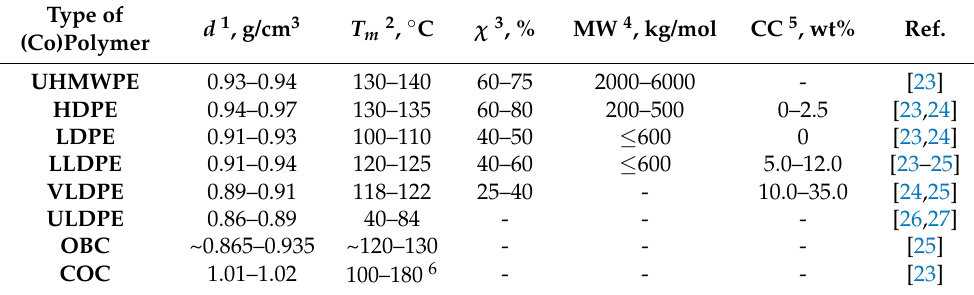
Table 3. Properties of LDPE and main polyethylene and ethylene copolymers grades produced using transition metal